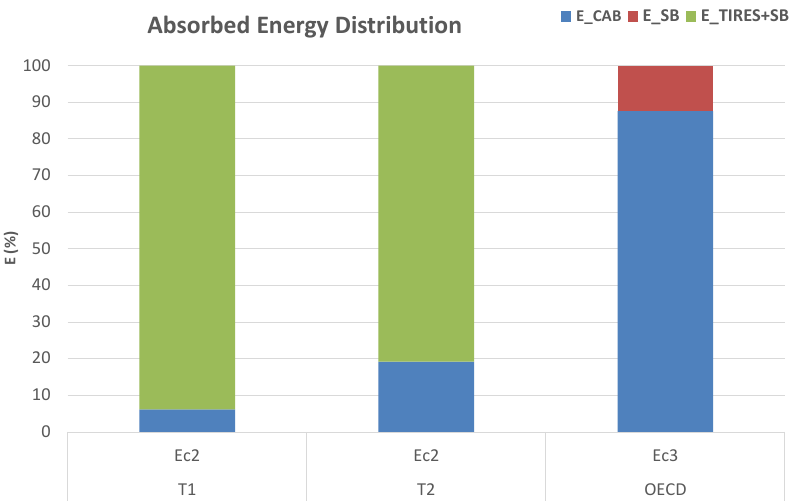
Figure 13. Energy E C2 values for T1 and T2 configurations compared with the OECD test energy E C3.